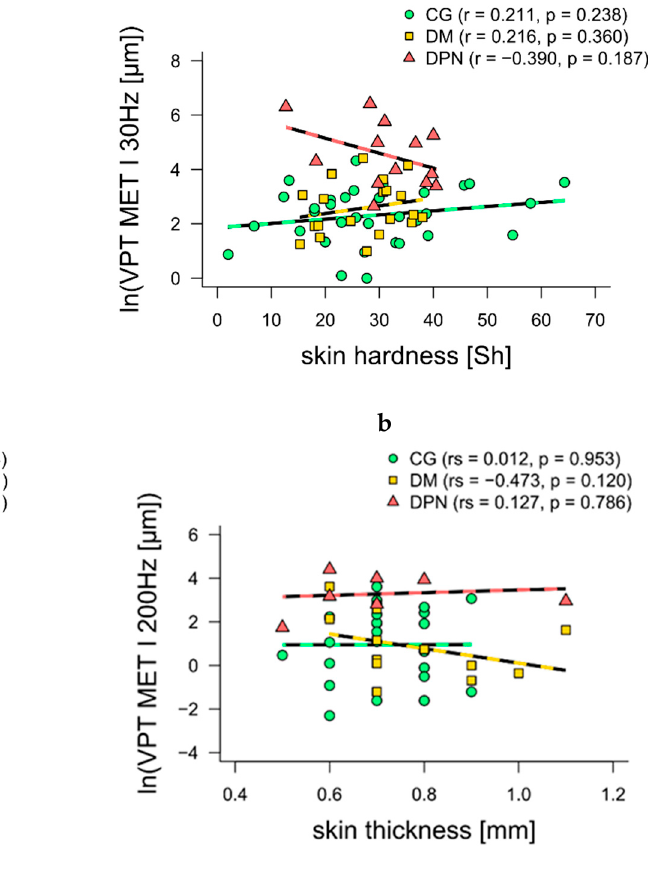
b Figure 2. Spearman’s rank-order (rs) and Pearson’s product-moment (r) correlations between skin hardness and skin thickness separated by groups. ( a ) Scatter plot of skin hardness versus skin thickness at first metatarsal head (MET I) for control group (CG, green), individuals with diabetes without diabetic neuropathy (DM, yellow) and individuals with diabetes with diabetic neuropathy (DPN, red). ( b ) Scatter plot of skin hardness versus skin thickness at heel for control group (CG, blue), individuals with diabetes without diabetic neuropathy (DM, yellow) and individuals with diabetes with diabetic neuropathy (DPN, red). Furthermore, 30 Hz VPTs at the heel and MET I showed moderate-to-high negative correlations ( p = 0.020 and p = 0.187, respectively) with skin hardness for DPN (Figure